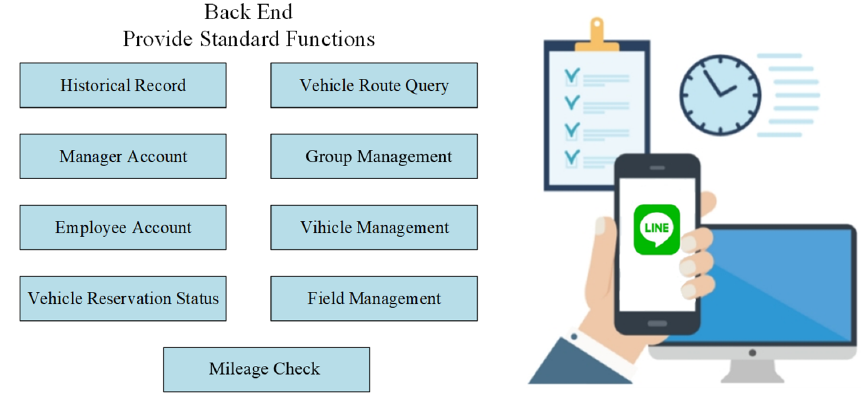
Figure 13. Back-end management system diagram.